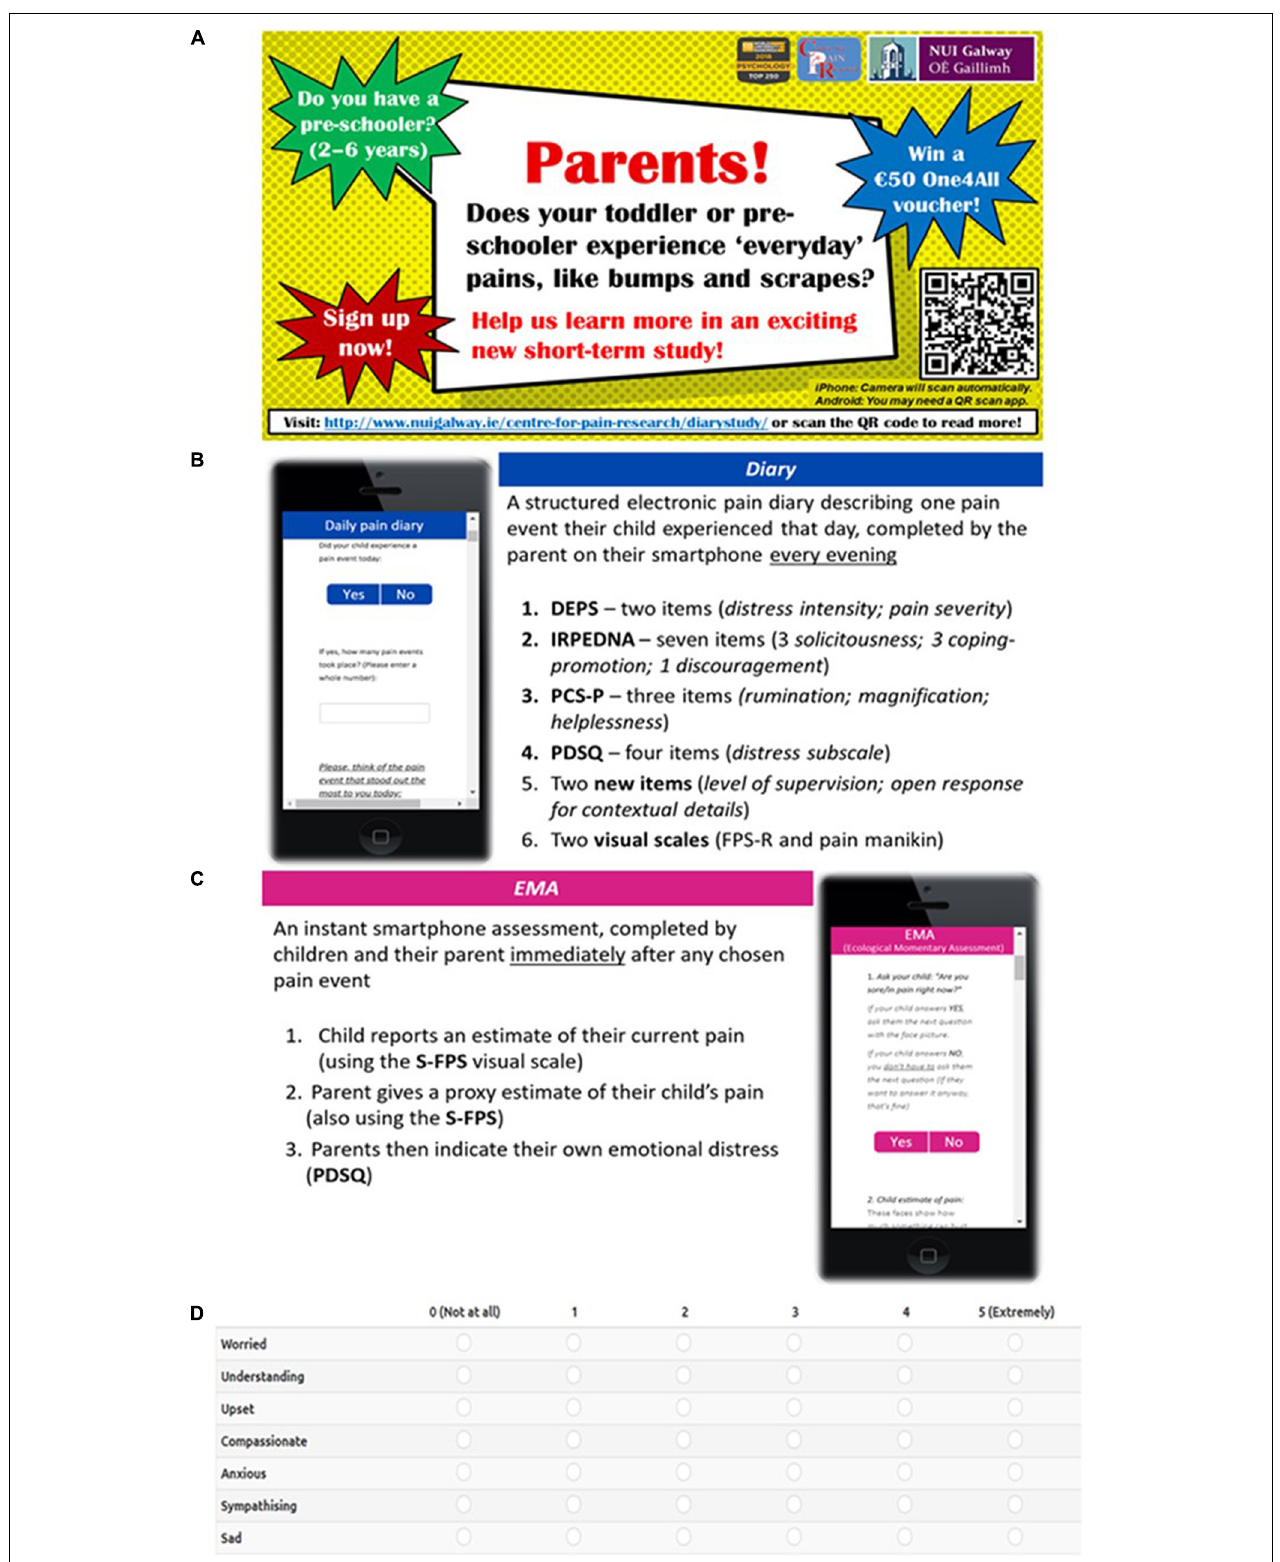
FIGURE 1 | Participant materials: (A) Recruitment flyer; (B) Overview of diary completion process; (C) Overview of EMA completion process; (D) Example of the PDSQ scoring scale as viewed on-screen during the EMA.